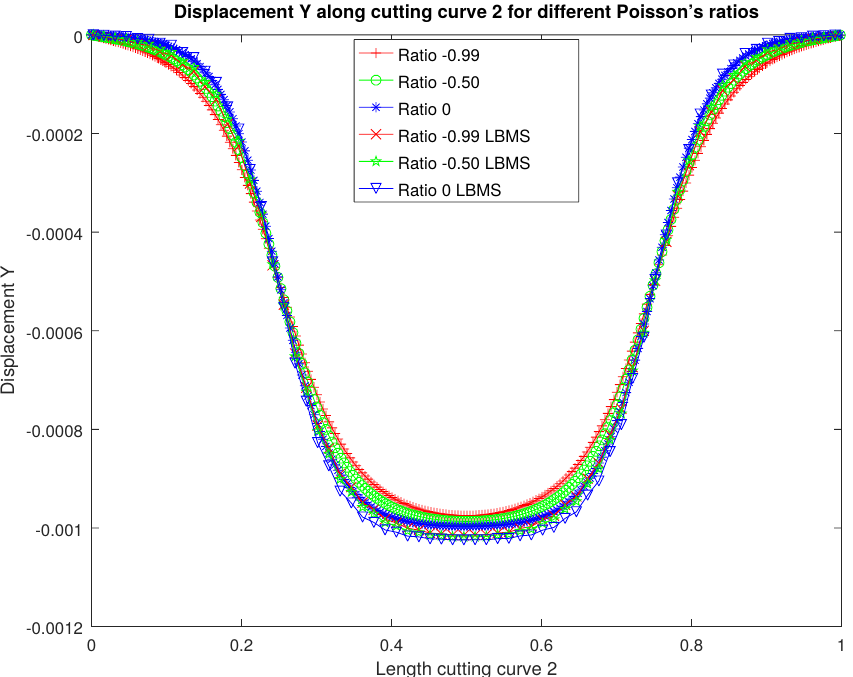
Figure A11. Second displacement components along cutting curve C 2 for negative Poisson’s ratios.